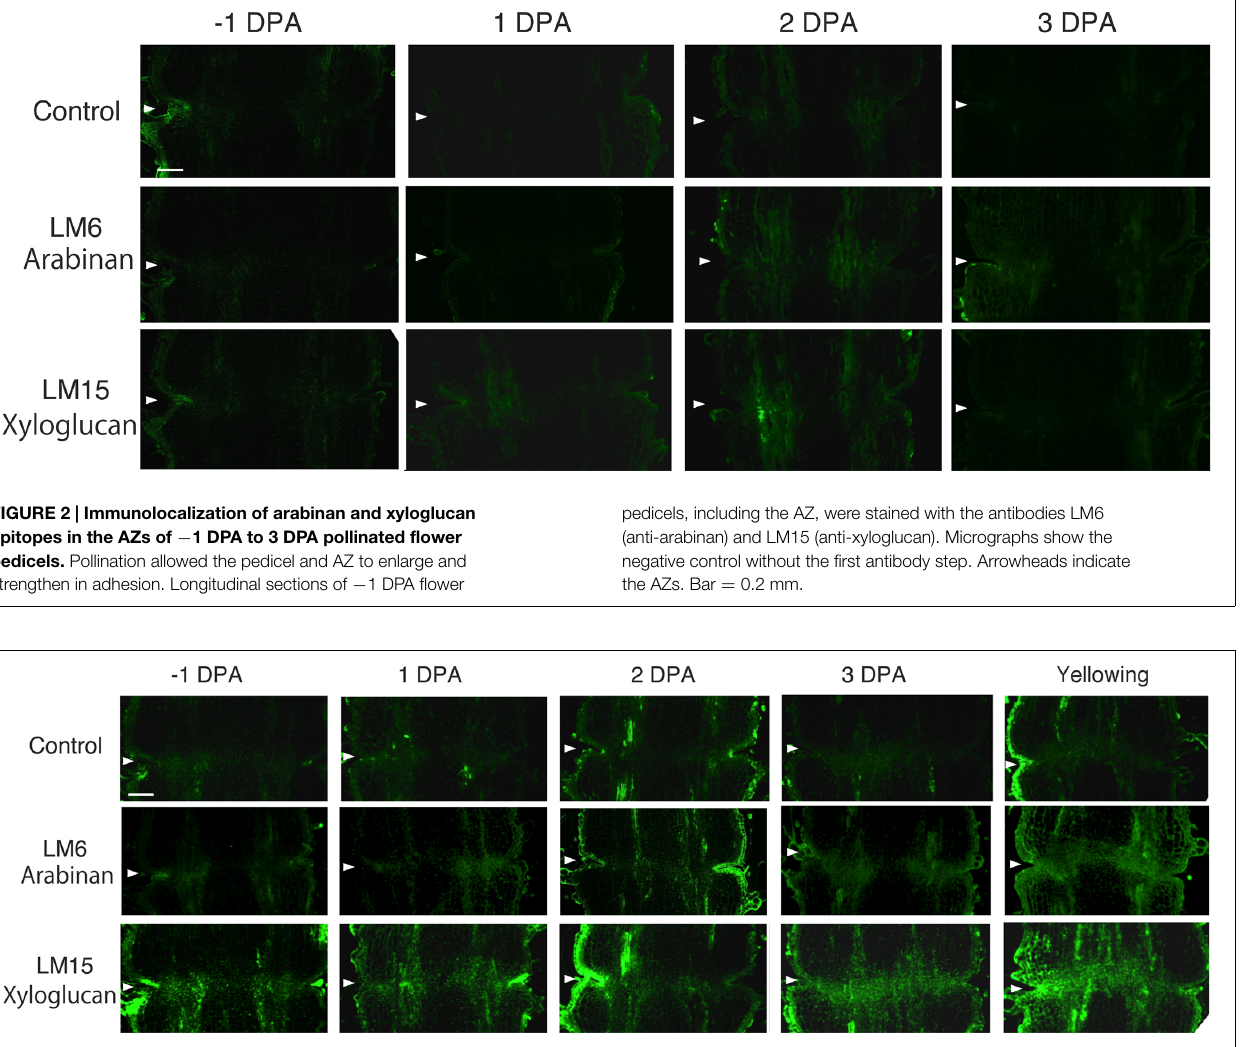
FIGURE 3 | Immunolocalization of arabinan and xyloglucan epitopes in the AZs of (cid:0) 1 DPA to yellowing unpollinated flower pedicels. Unsuccessful pollination led to flower abscission. Longitudinal sections of (cid:0) 1 DPA flower pedicels,